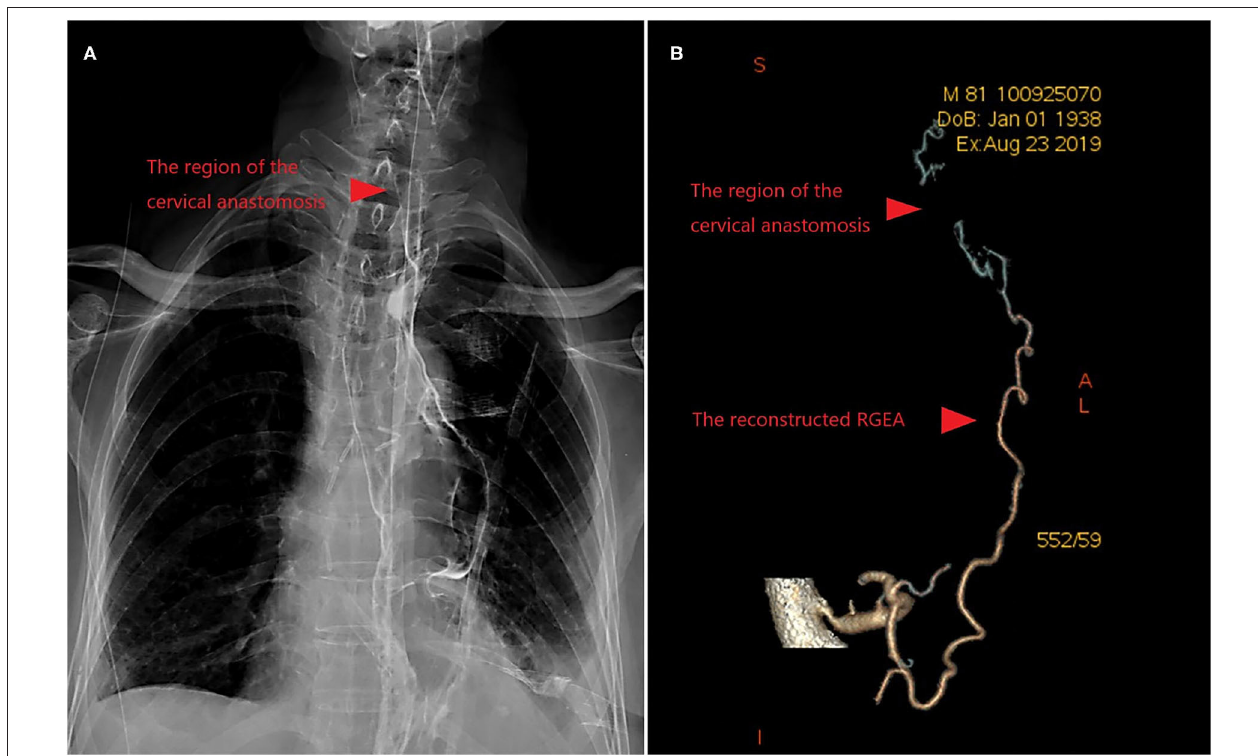
FIGURE 1 | (A) Upper Gastrointestinal Contrast showed that there was no anastomosis leakage after 2 weeks of conservative treatment. (B) The postoperative assessment of blood supply was good revealed by Contrast-Enhanced